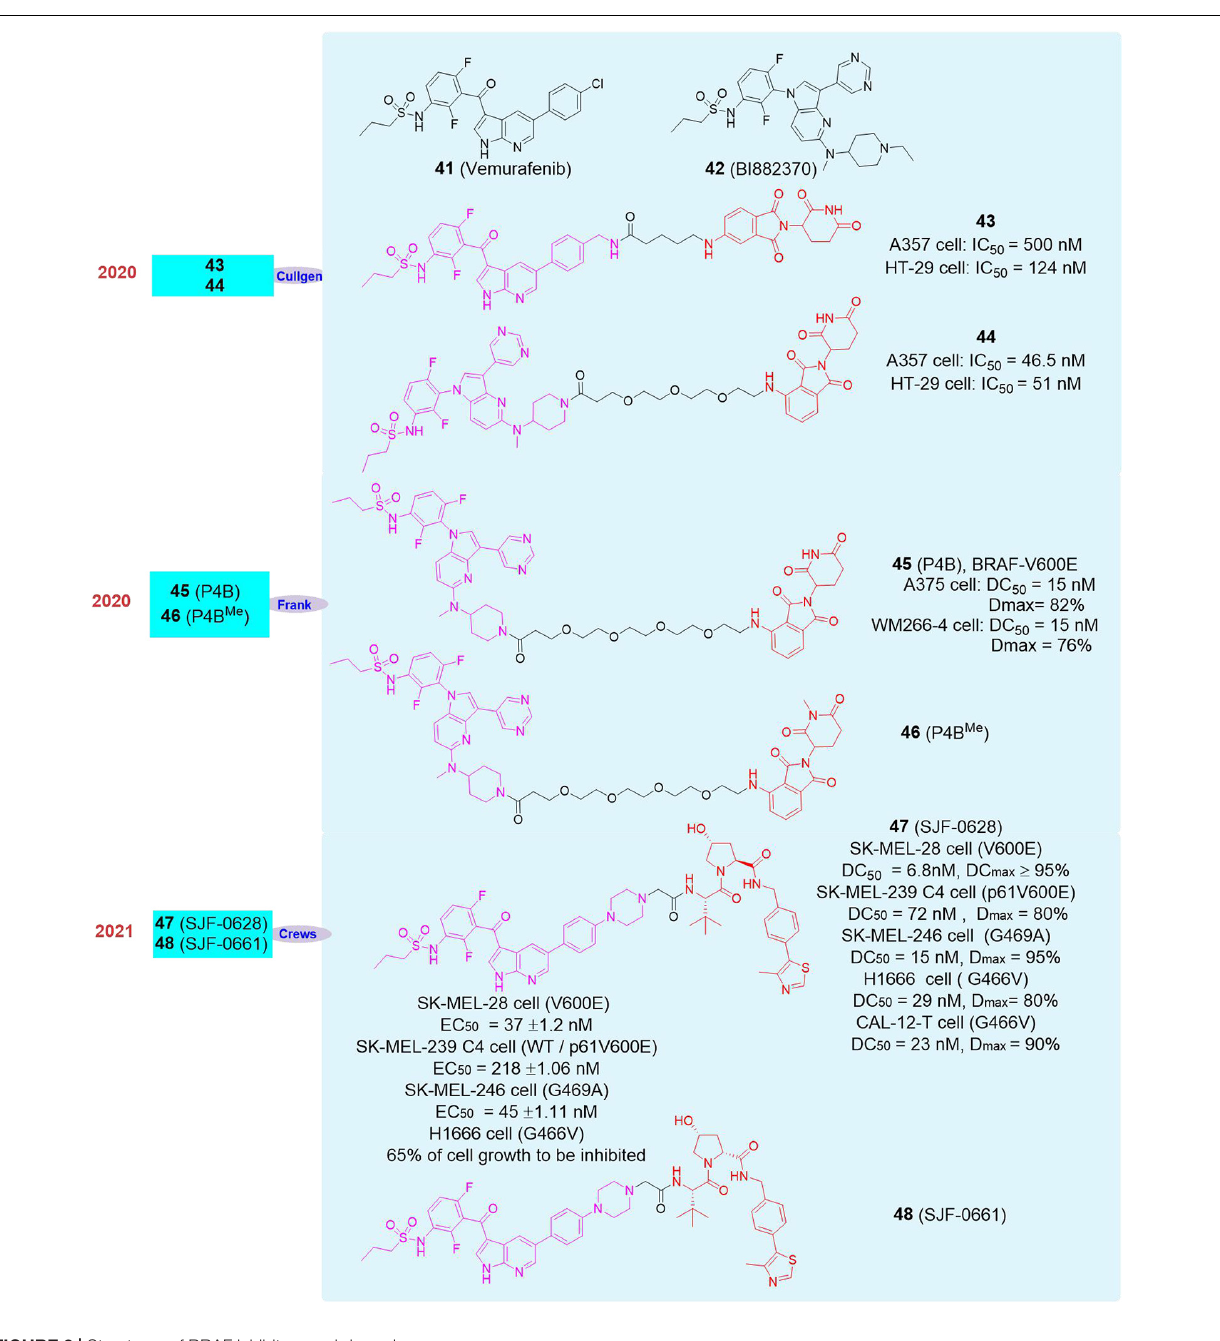
FIGURE 8 | Structures of BRAF inhibitors and